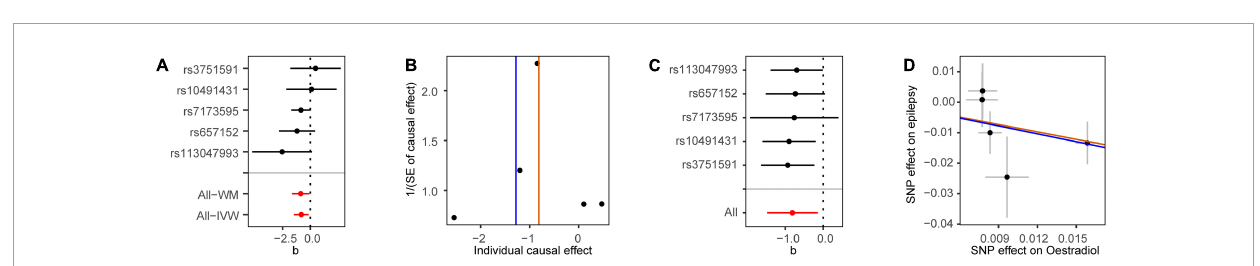
FIGURE2 Mendelian randomization analysis results for estradiol in males on the risk of epilepsy. (A) Forest plot of the causal effect of estradiol in males on epilepsy. (B) Funnel plot showing the estimation using the inverse of the standard error of the causal estimate with each individual SNP as a tool. The vertical line represents the estimated causal effect. SNP, single nucleotide polymorphism. (C) Forest plot of the results of the leave-one-out sensitivity analysis, where each SNP was iteratively removed from the instrumental variables. (D) Scatter plot of SNP effects on estradiol in males and epilepsy. The 95% CI for the effect size on epilepsy is shown as vertical lines, while the 95% CI for the effect size on estradiol in males is shown as horizontal lines. The slope of fitted lines represents the estimated MR effect per method.